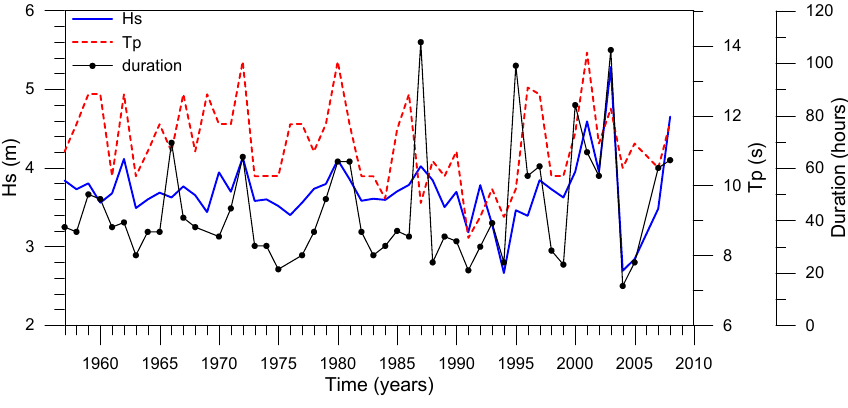
Fig. 4. Reconstructed wave variables defining annual maxima storms for sector III.